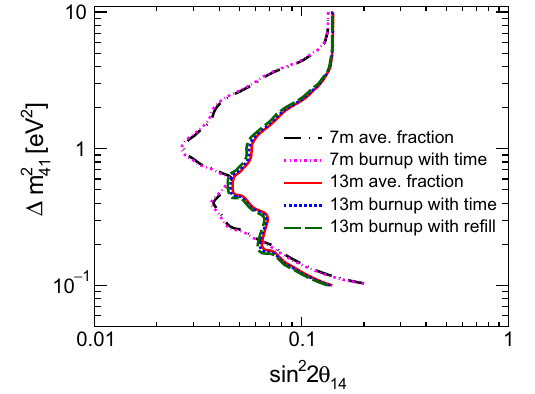
− 41 ( 1 − U ) 2 , expected from e 4 e 4